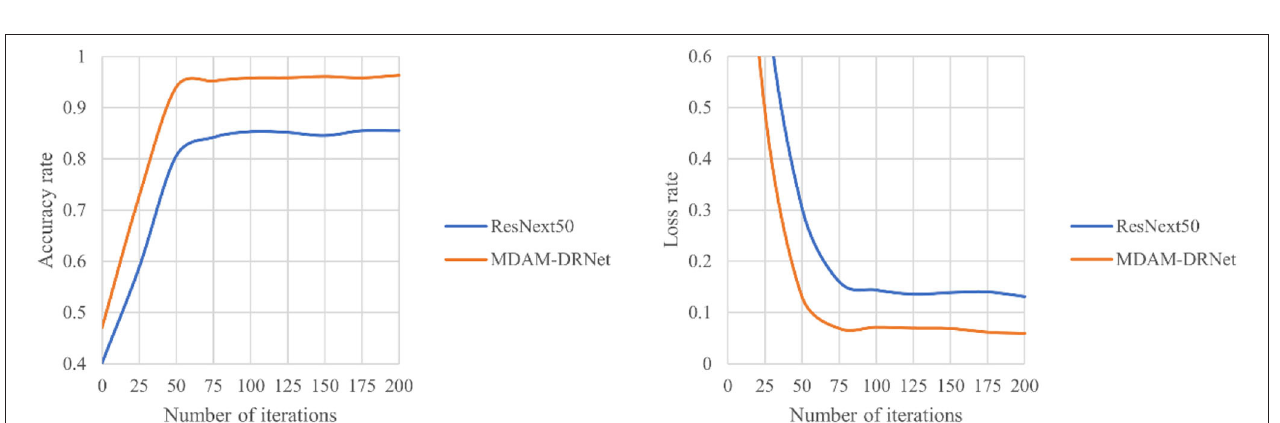
FIGURE 10 | The identification accuracy curves of MDAM-DRNet and ResNeXt for strawberry leaf diseases under the same data set.